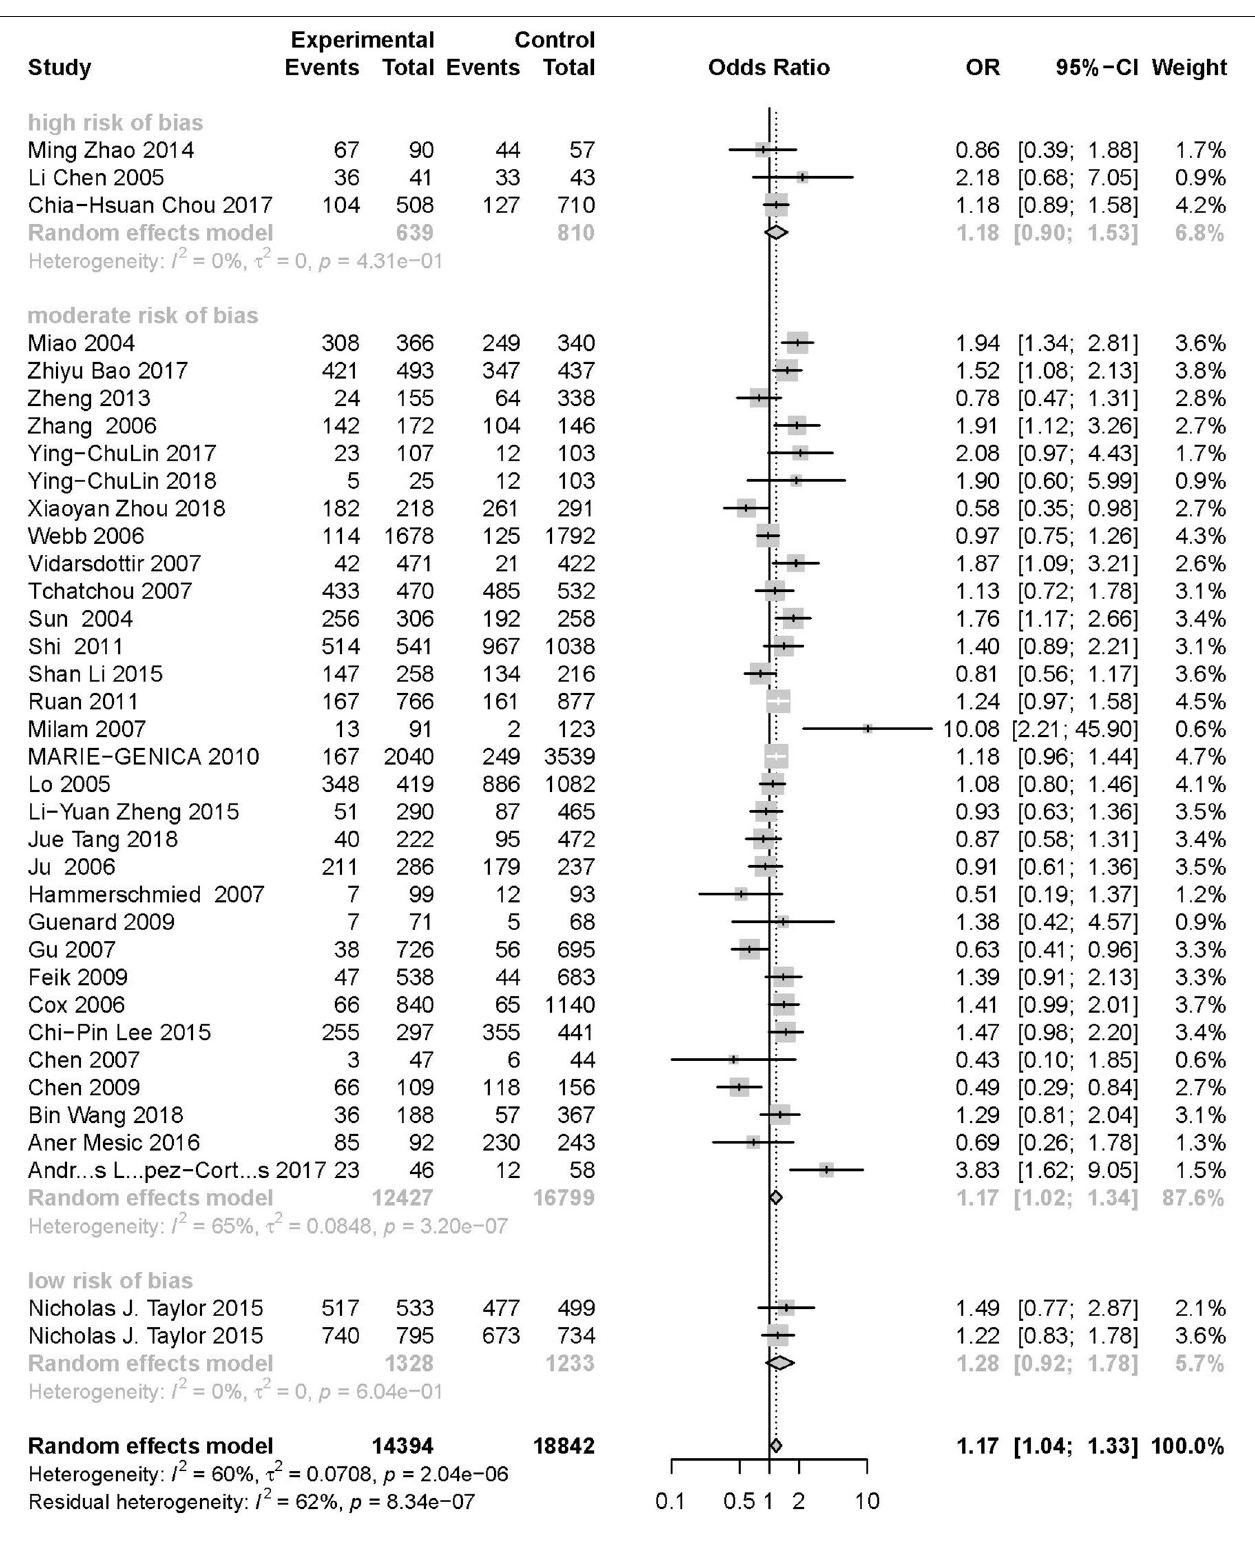
FIGURE 6 | Stratification analysis of the association between the AURKA rs2273535 T > A polymorphism and cancer risk by risk of bias under the homozygous model (AA vs. TT).